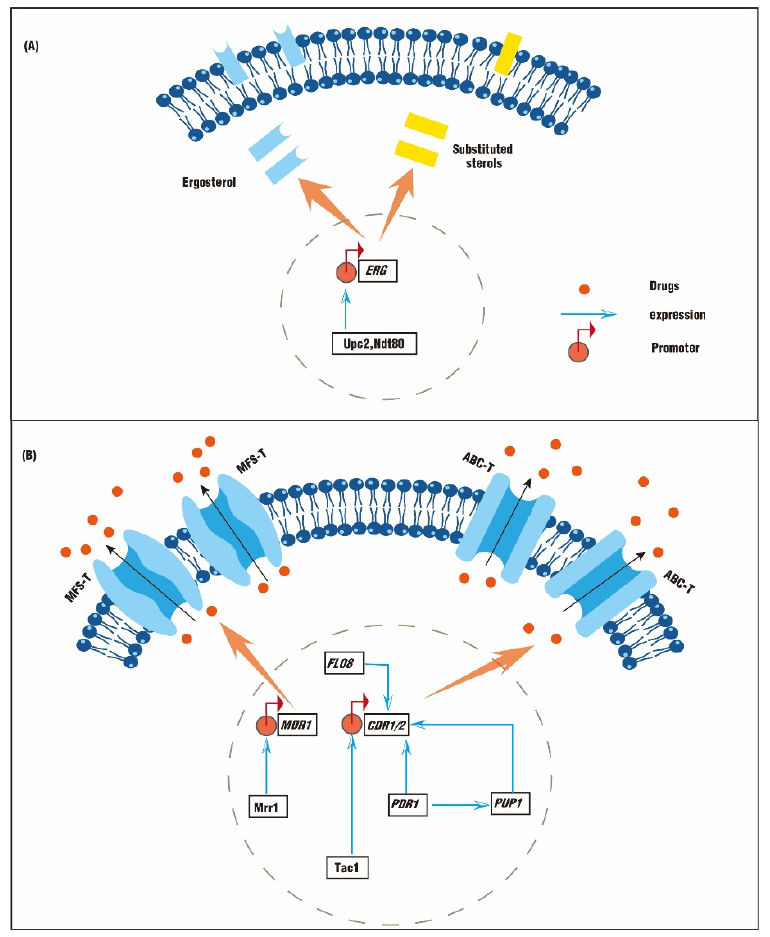
Figure 1. The mechanisms of drug resistance in fungi. ( A ) The resistance is induced by abnormal sterol substitution or accumulation. ( B ) The resistance is induced by abnormal efflux pump function.